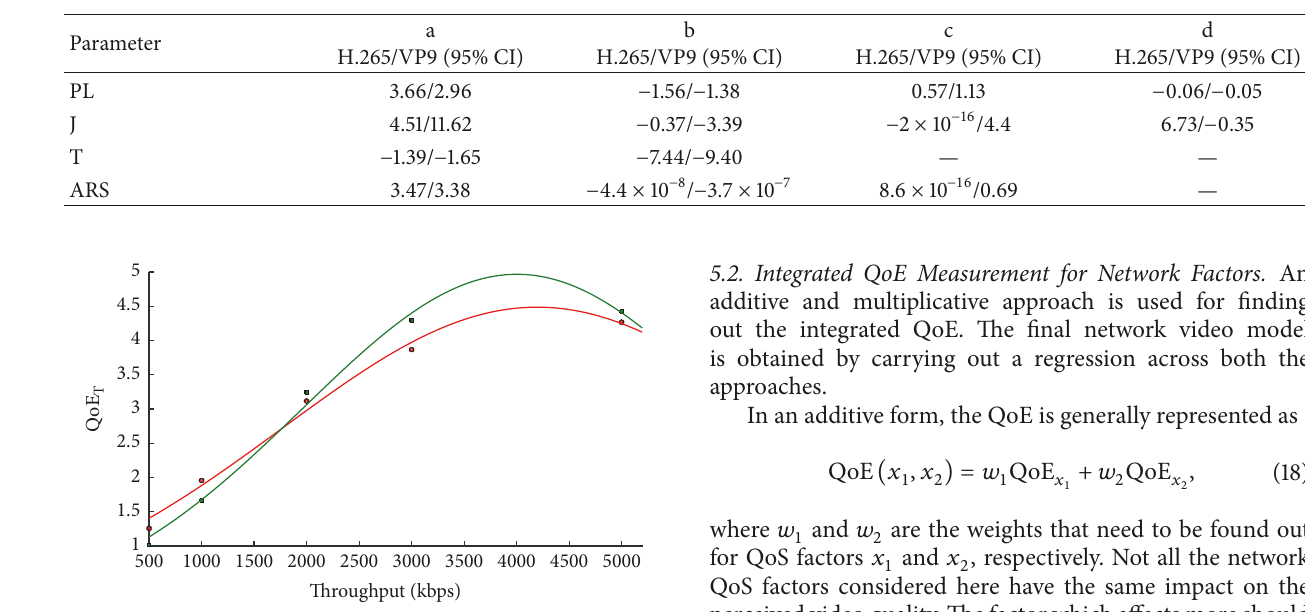
Table 10: Coefficient values for network factors.